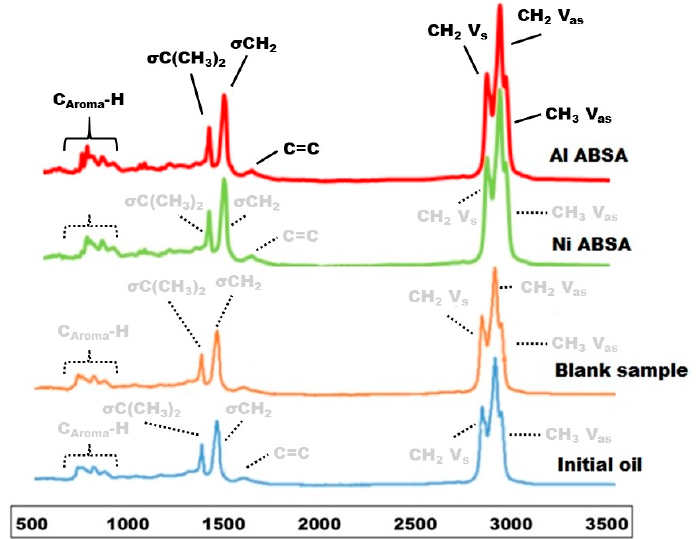
Figure 8. FTIR spectra of crude oil samples.